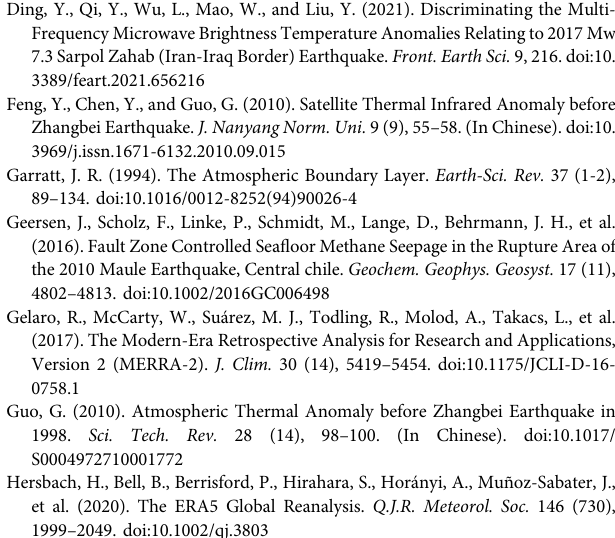
Supplementary Figure S1 | The time series of SSR over Bohai Sea 1 month about before and after Zhangbei earthquake (seismic anomaly appeared on the day labeled in red). Supplementary Figure S2 | The time series of ER over Bohai Sea 1 month about before and after Zhangbei earthquake (seismic anomaly appeared on the day labeled in red). Supplementary Figure S3 | The time series of CO concentration over Bohai Sea 1 month about before and after Zhangbei earthquake (seismic anomaly appeared on the day labeled in red). Supplementary Figure S4 | The time series of SSS concentration over Bohai Sea 1 month about before and after Zhangbei earthquake (seismic anomaly appeared on the day labeled in red). Supplementary Figure S5 | The time series of CBH over Bohai Sea 1 month about before and after Zhangbei earthquake (anomaly appeared on the day labeled in